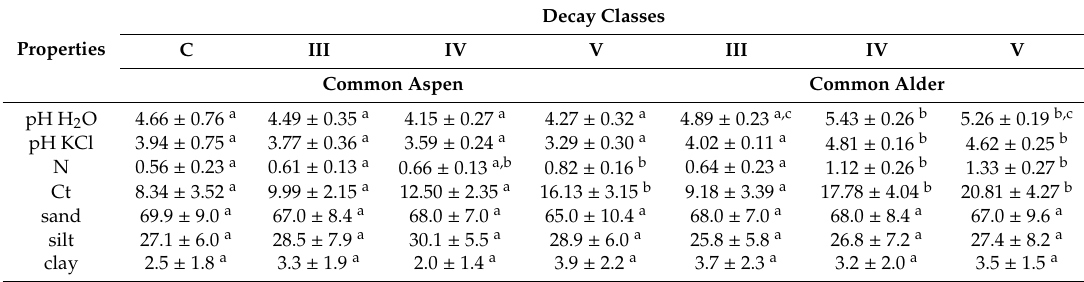
Table 4. pH, carbon and nitrogen content in soil collected under deadwood and from the background (control